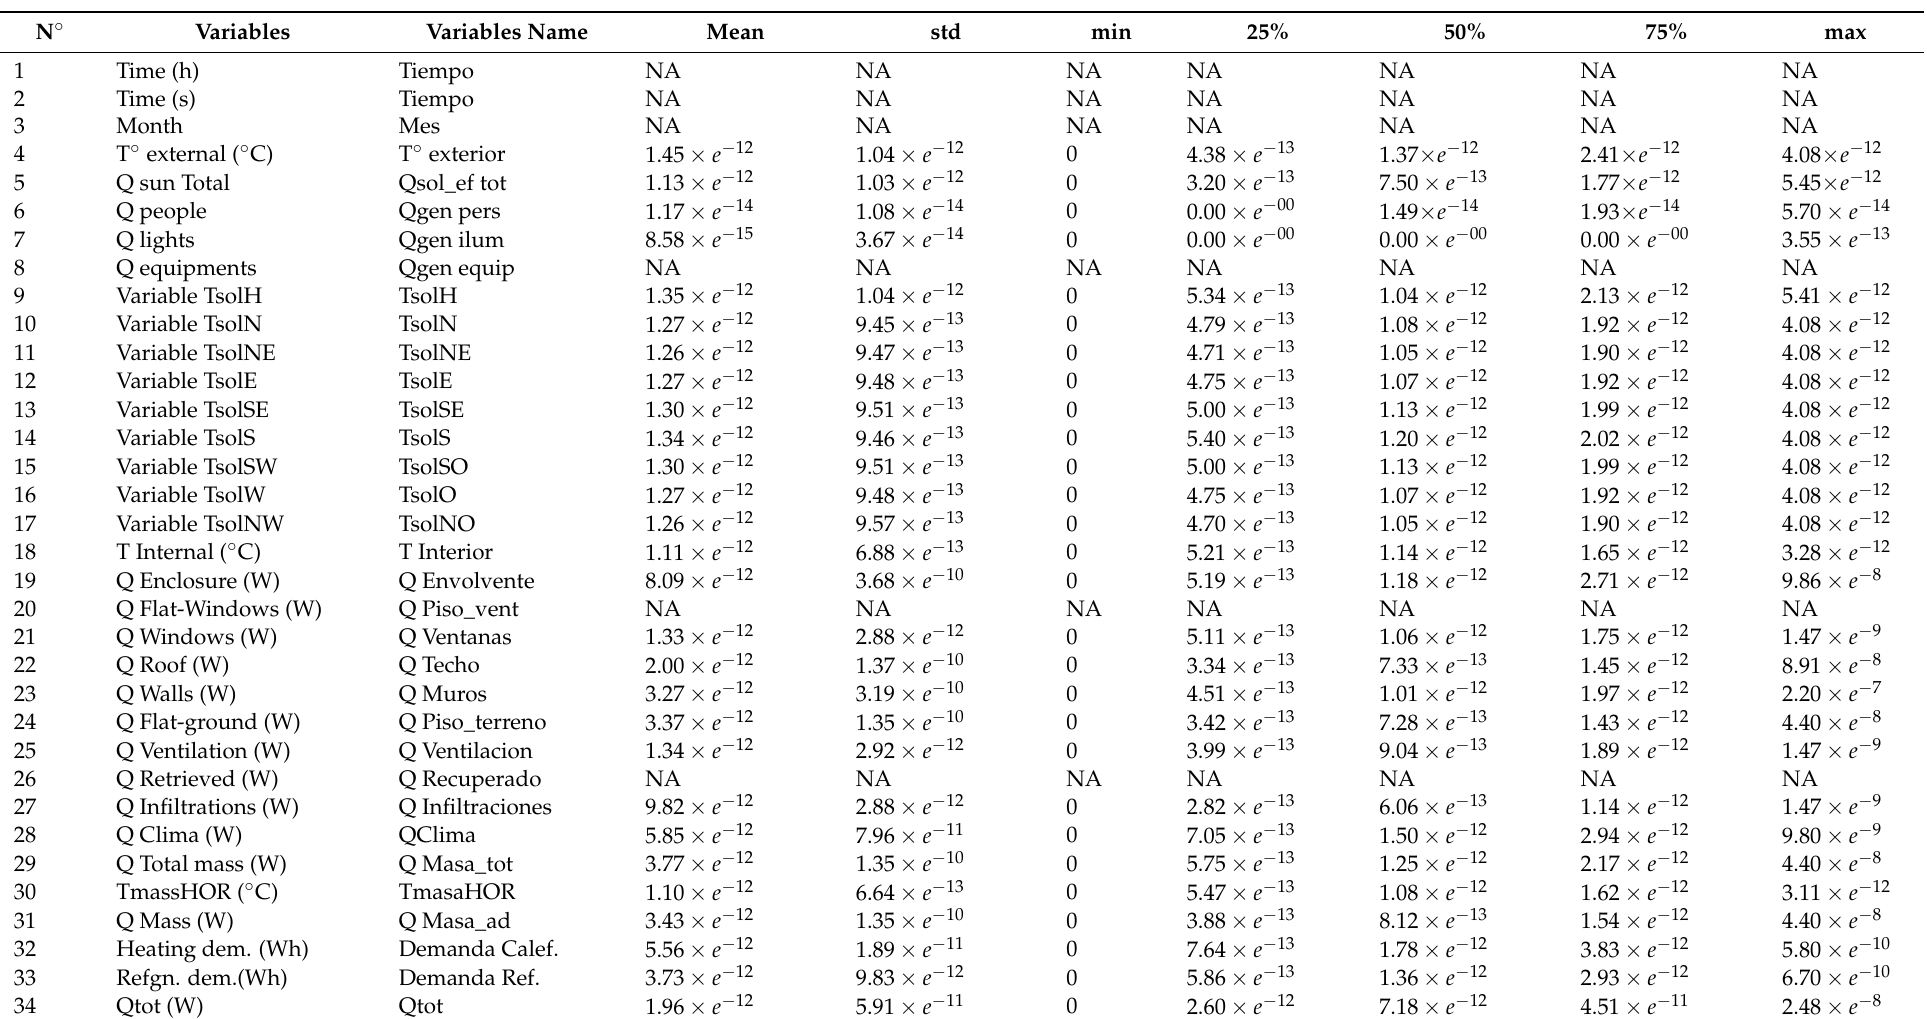
Table 6. Summary of the comparison of